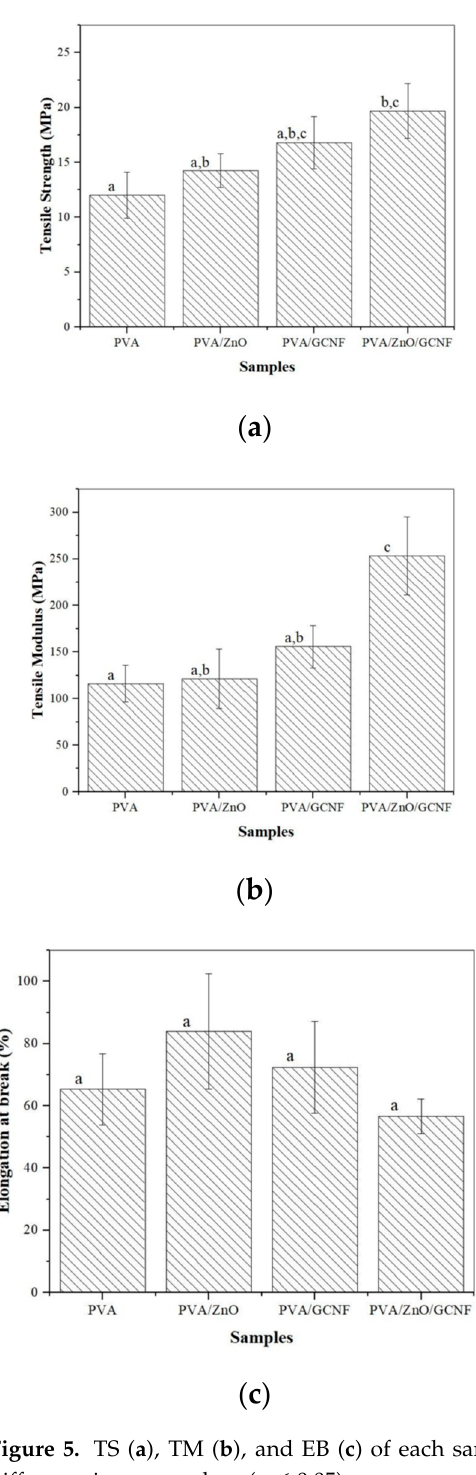
Figure 5. TS ( a ), TM ( b ), and EB ( c ) of each sample. Different letters ( a – c ) denote a significant difference in mean values ( p ≤ 0.05).